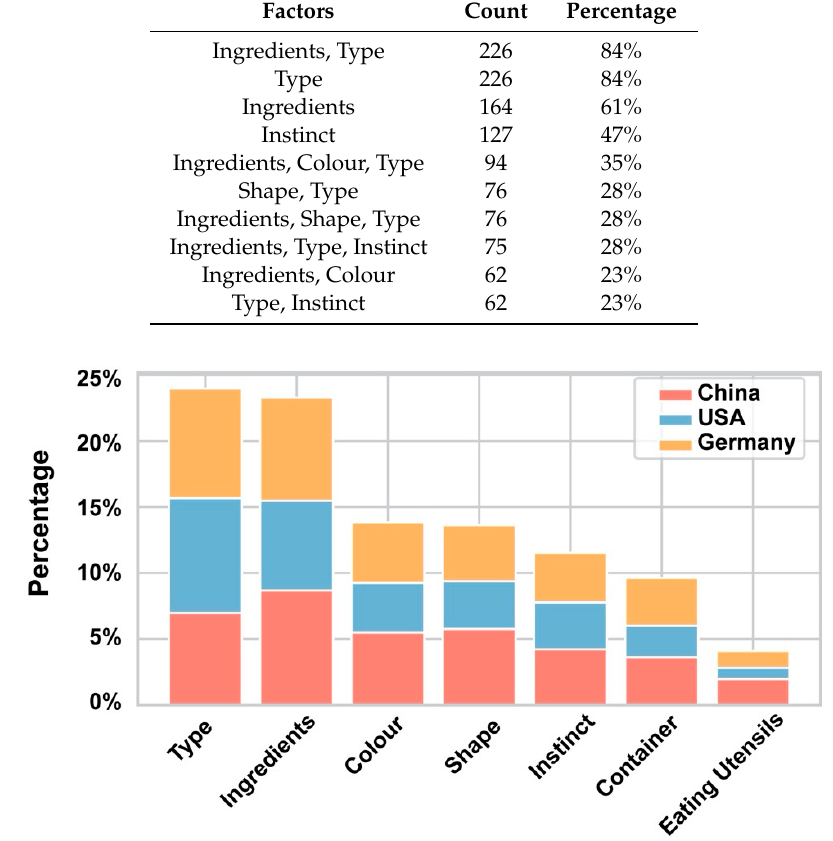
Figure 7. The percentage based on frequency of each single factor chosen by the participants.